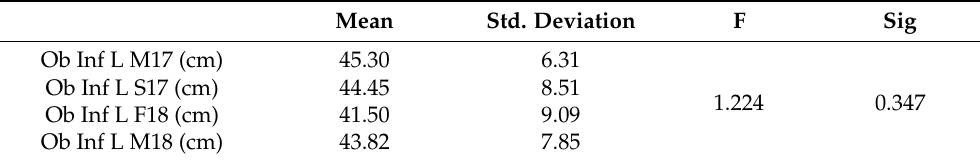
Table 8. OB values in the inferolateral direction of the left arm. Mean Std.